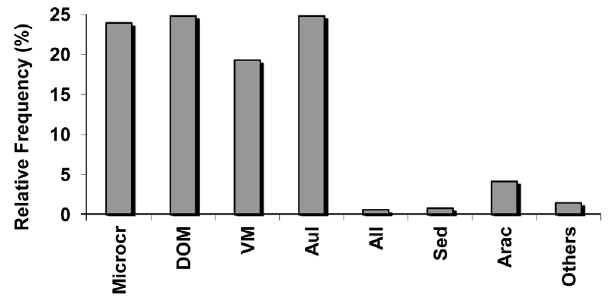
Figure 8. Percent composition of the alimentary categories. Percent composition of the alimentary categories established for Brachyhypopomus gauderio . Microc= microcurstacea; DOM= digested organic material; VM= vegetal material; AuI= autochthonous insects; AlI= allochthonous insects; Sed= sediment; Arac= arachnid; Others= other items; number of specimens analyzed=